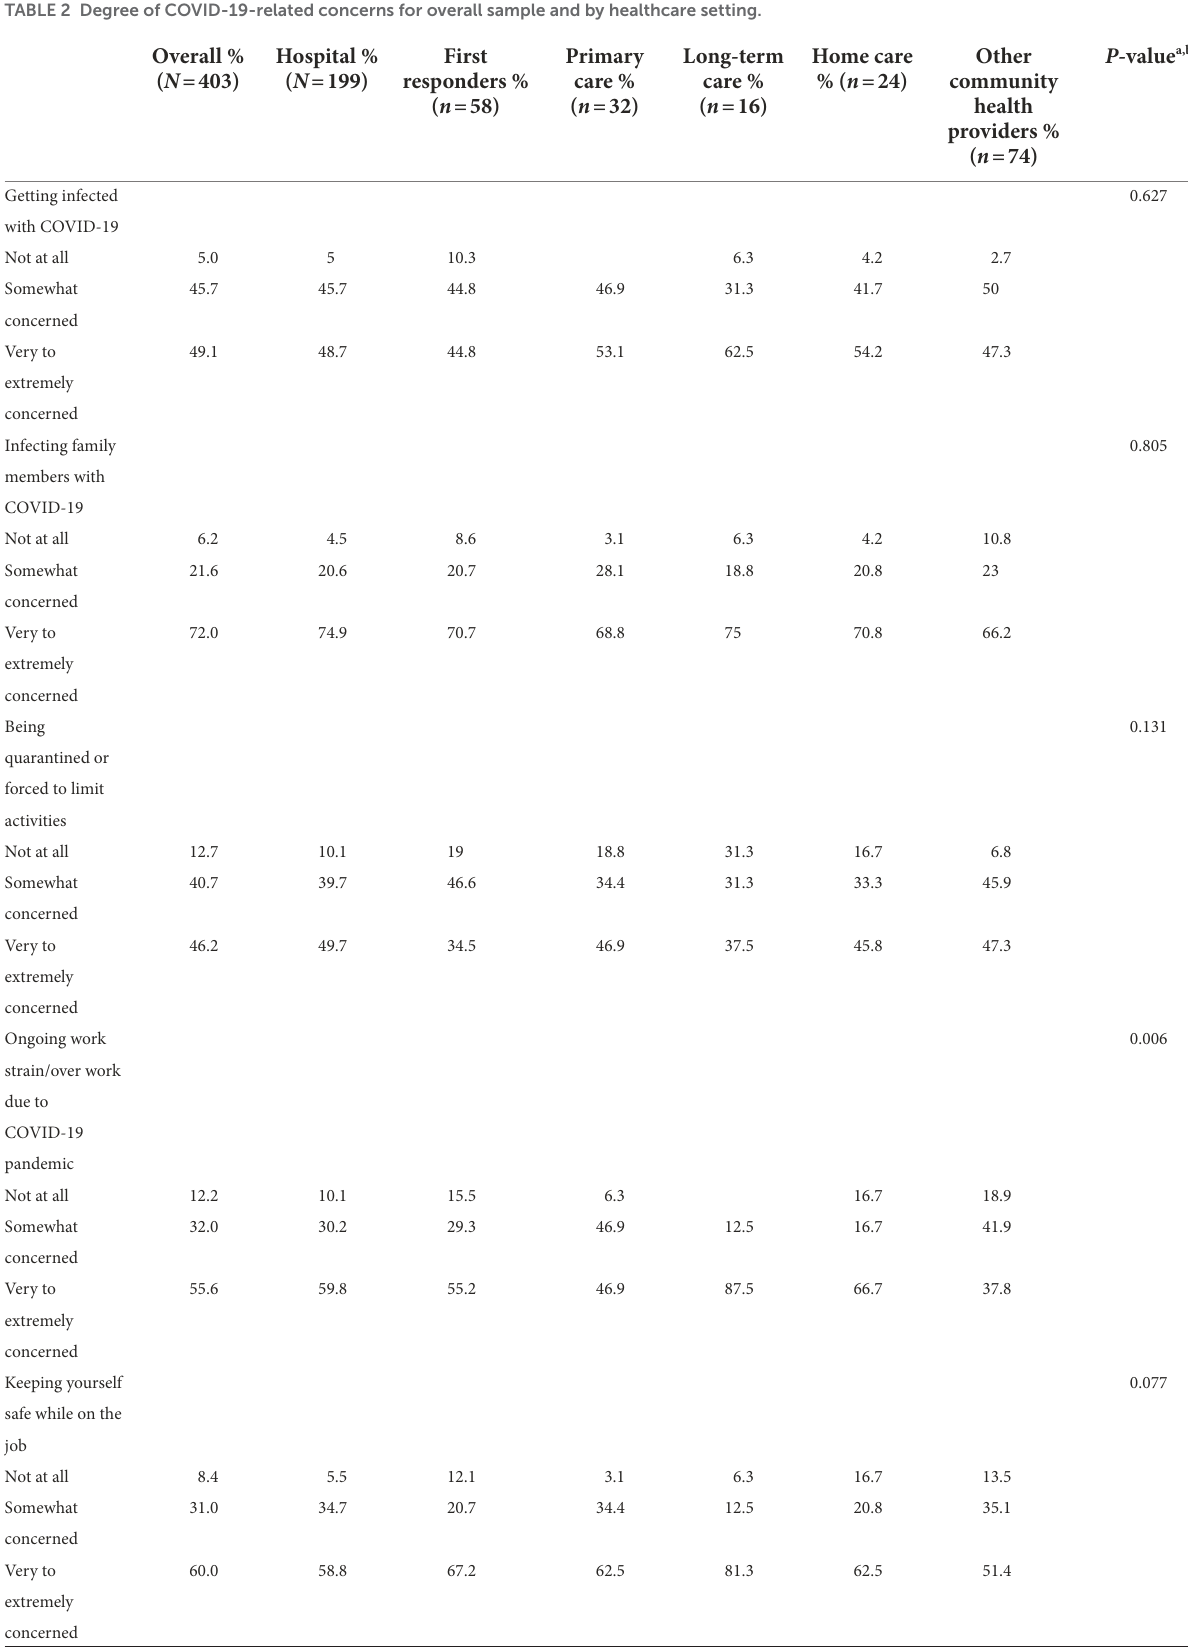
TABLE 2 Degree of COVID-19-related concerns for overall sample and by healthcare setting. Overall % Hospital % ( N = 403) ( N =